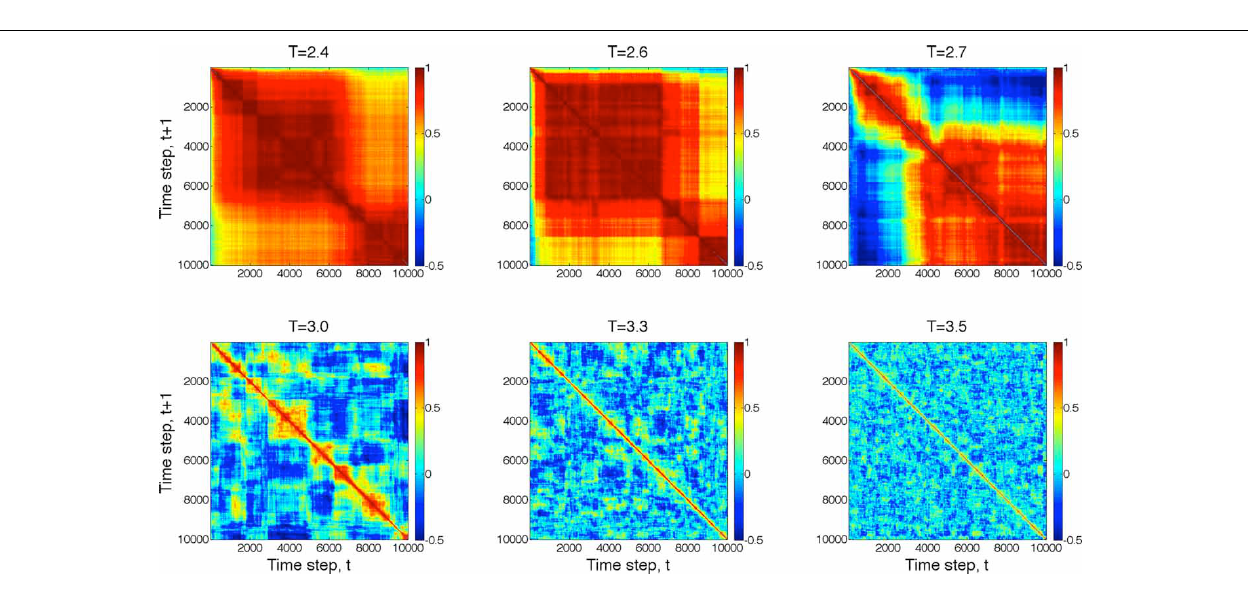
consecutive patterns. Metastable states are formed at T = 2.7 suggesting critical, “edge-of-chaos” behavior. Higher T leads to more random patterns, whereas lower T yields hyper-synchronous, stereotypic